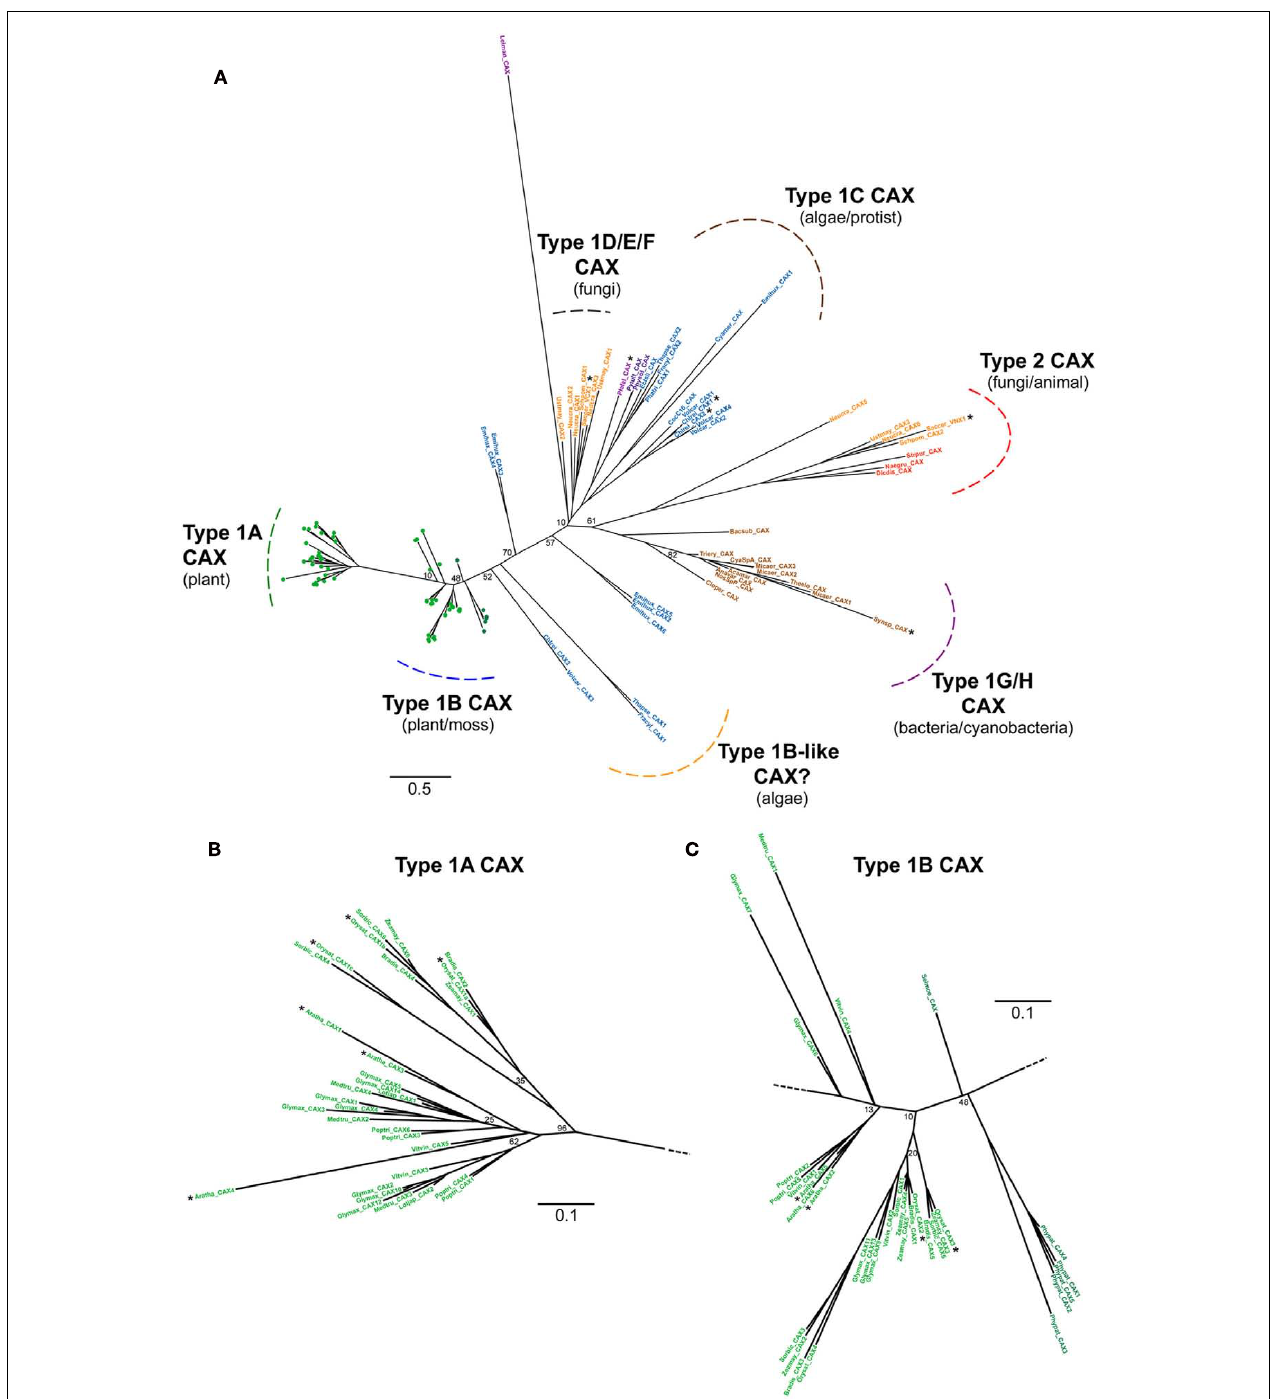
Type 1A and 1B groups are replaced by circles and the gene name labels are given in the enlarged tree sections in (B,C) . Bootstrap values are indicated at the nodes of major branches.The branch length scale bar indicates the evolutionary distance of 0.5 amino acid substitutions per site [0.1 amino acid substitutions per site in (B,C) ]. Genes that are highlighted with an asterisk encode transporters for which the ion specificity has been